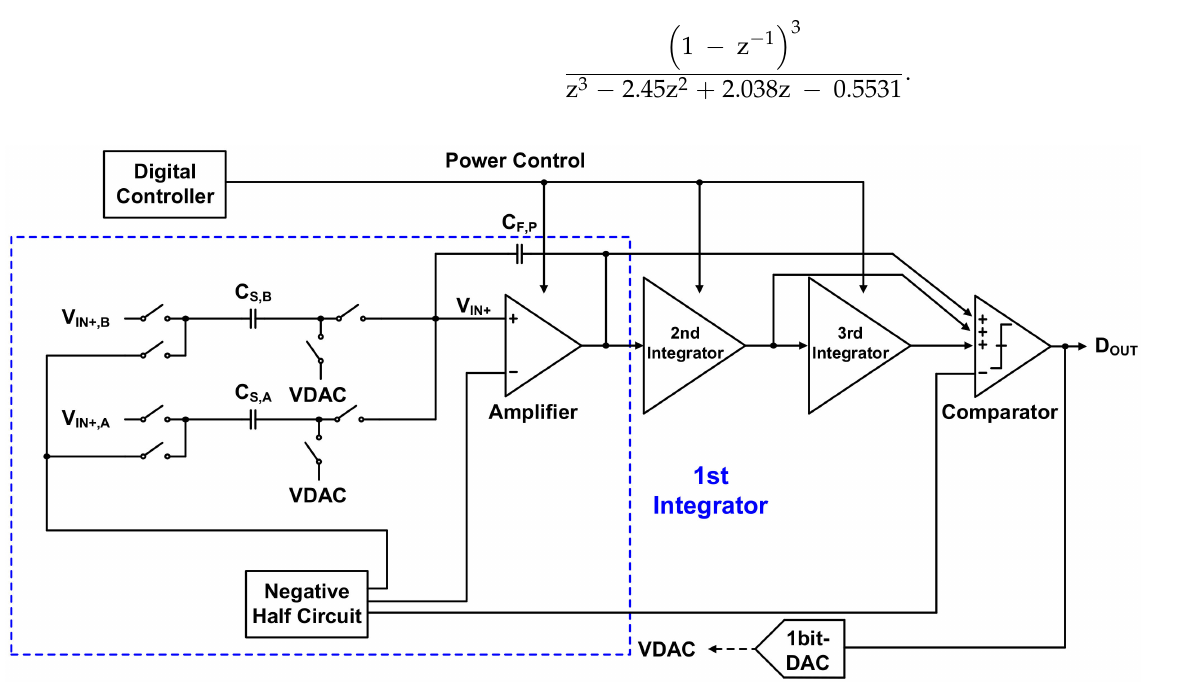
Figure 16. Third-order delta-sigma analog-to-digital converter.